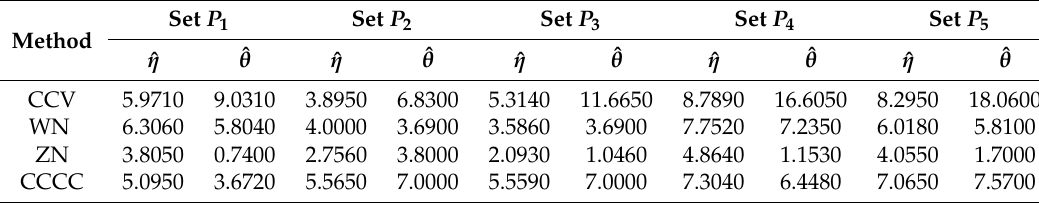
Table 11. Robustness for sets P 1 , P 2 , P 3 , P 4 , P 5